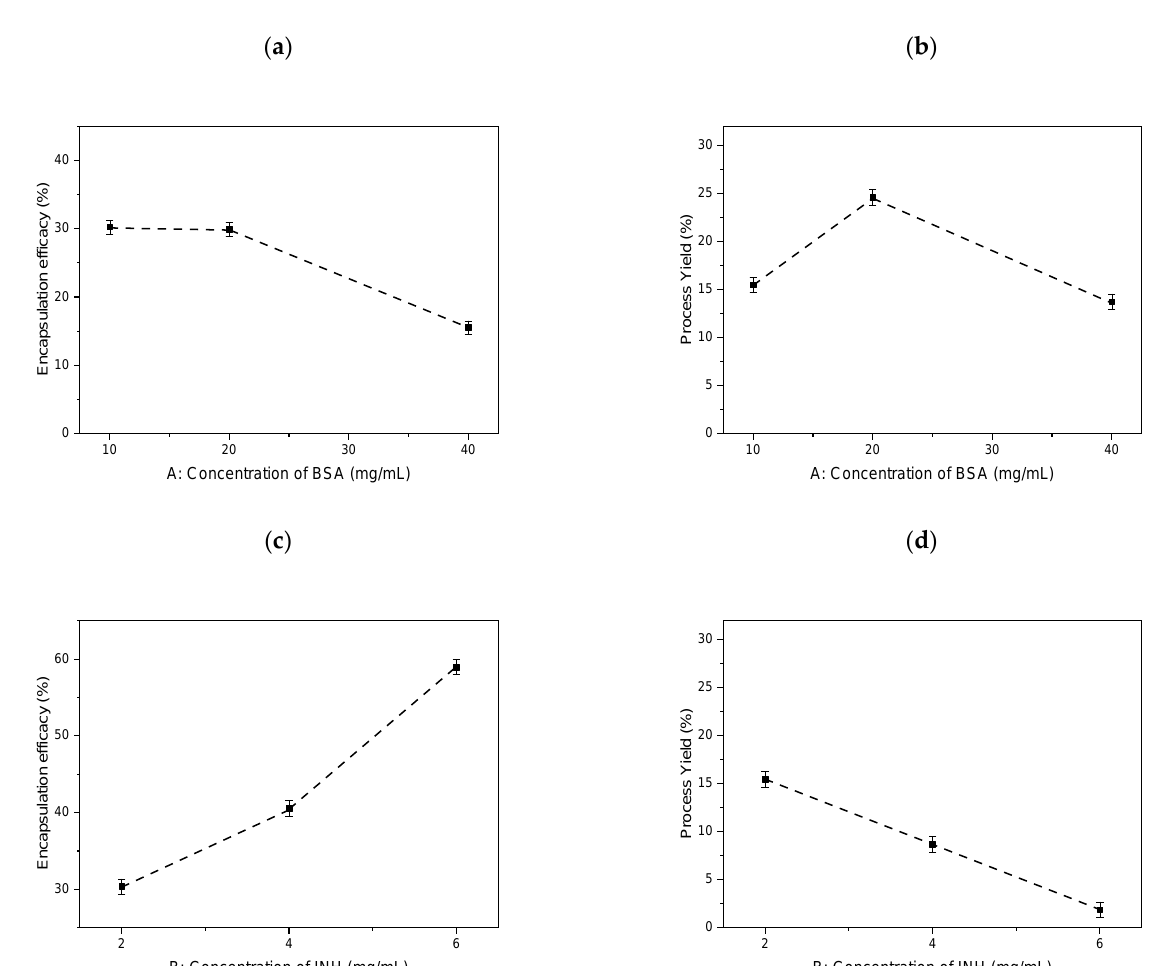
Figure 3. Influence of parameters on EE: ( a ) Concentration of BSA, ( c ) Concentration of INH and NPs yield: ( b ) Concentration of BSA, ( d ) Concentration of INH.